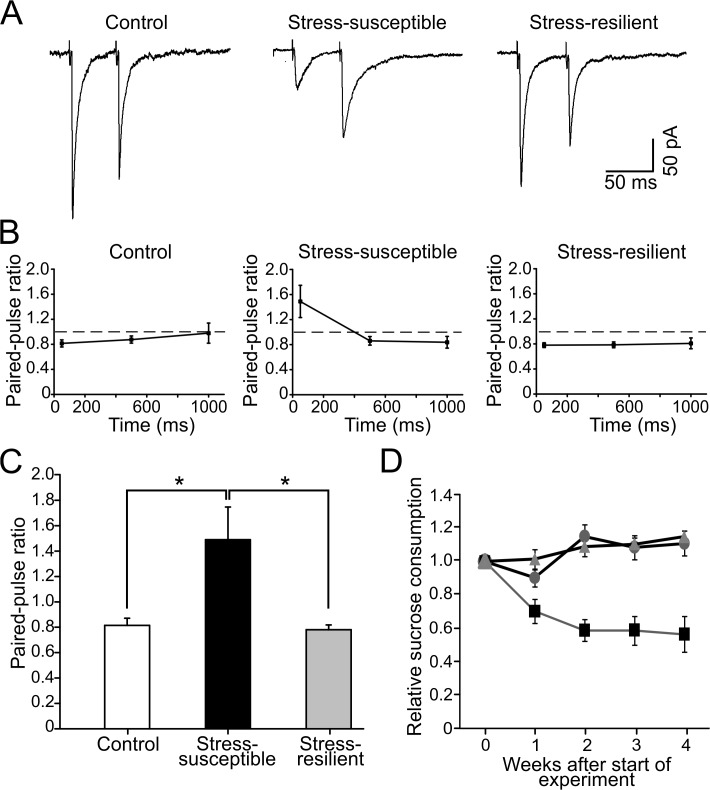
Paired-pulse depression of evoked IPSCs turns into facilitation in stress-susceptible, but not stress-resilient, rat dentate gyrus granule cells.A. Evoked GABAA receptor mediated IPSCs showing paired-pulse behavior in granule cells from unchallenged control, stress-susceptible and stress-resilient rats. Traces are averages of 10–15 sweeps. B. Line plot depicting the paired-pulse ratio at different inter-pulse intervals (50, 500 and 1000 ms) in the three groups. C. Bar graph showing the significant differences (P < 0.05) between control (n = 23 cells/6 rats), stress-susceptible (n = 21 cells/6 rats) and stress-resilient (n = 18 cells/6 rats) at a paired-pulse interval of 50 ms. Susceptible rats show paired-pulse facilitation, indicating a reduction in GABA release probability, while resilient rats are similar to control. D. Sucrose consumption for controls (circles), stress-resilients (triangles) and stress-susceptible (squares).